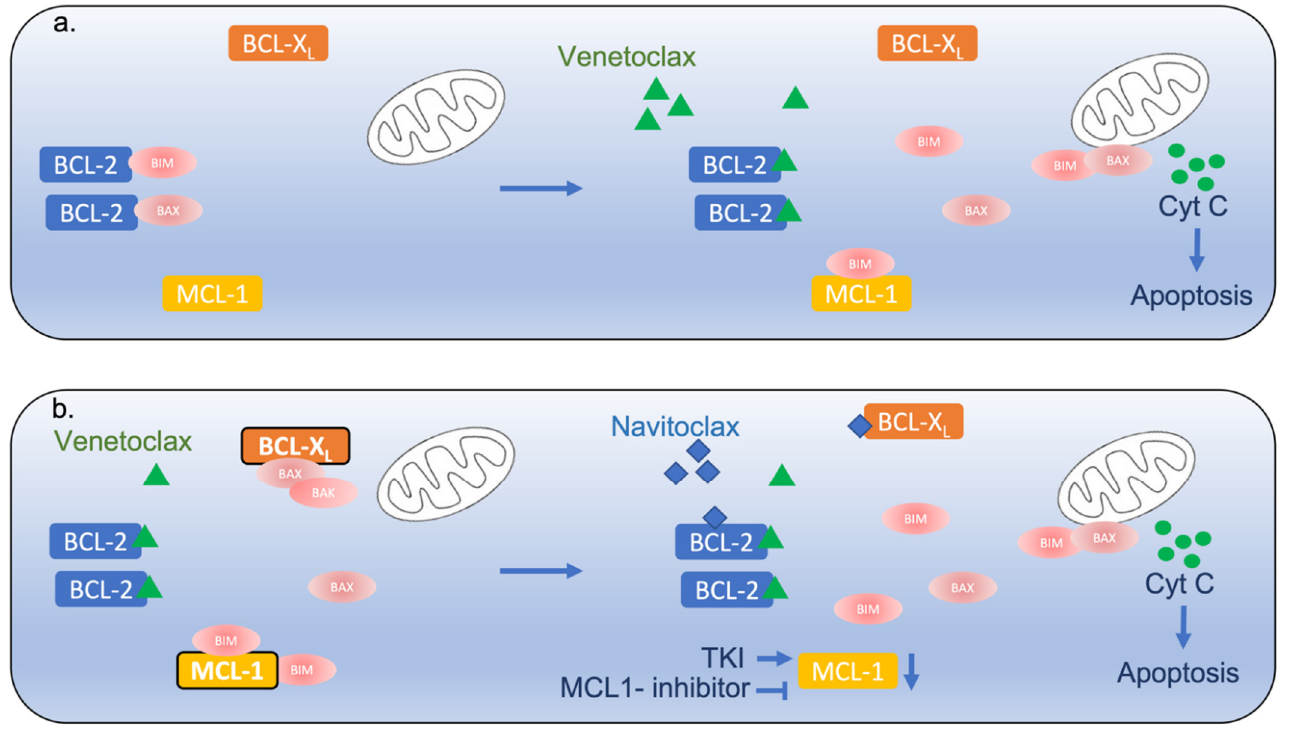
Figure 1. Interplay of BCL-2 family members in ALL. ( a ) Venetoclax binds to BCL-2 and displaces Bim and other BH3-only proteins (BAX), promoting activation of Bax and Bak and leading to their oligomerization and mitochondrial outer membrane permeabilization, cytochrome C release and caspase activation. ( b ) The upregulation of BCL-X L and MCL-1 results in sequestration of these effectors and venetoclax resistance. This can be potentially overcome by co-targeting these molecules as presented. TKI—tyrosine kinase inhibitor, Cyt C—cytochrome C.